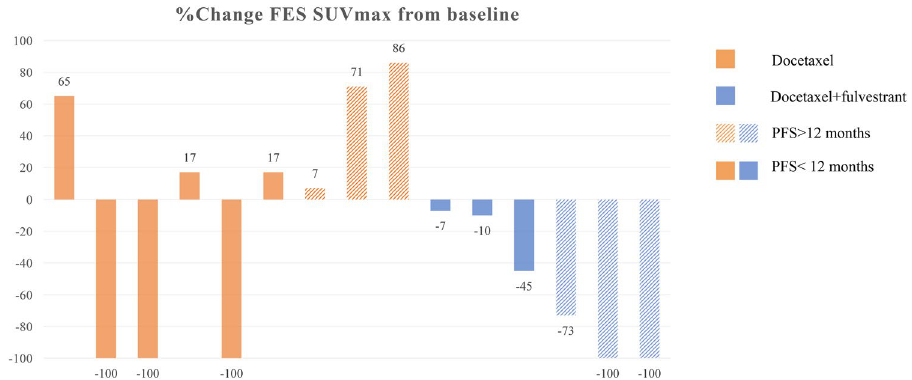
Figure 3. Waterfall plot showing the relative changes in tumor FES uptake in individual patients treated with docetaxel or docetaxel plus fulvestrant on follow-up scans, compared with baseline.